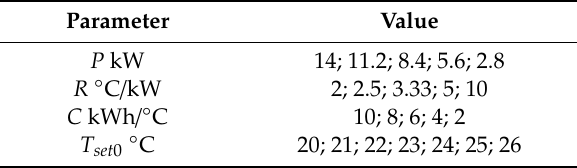
Table 1. Cluster center of the aggregated AC